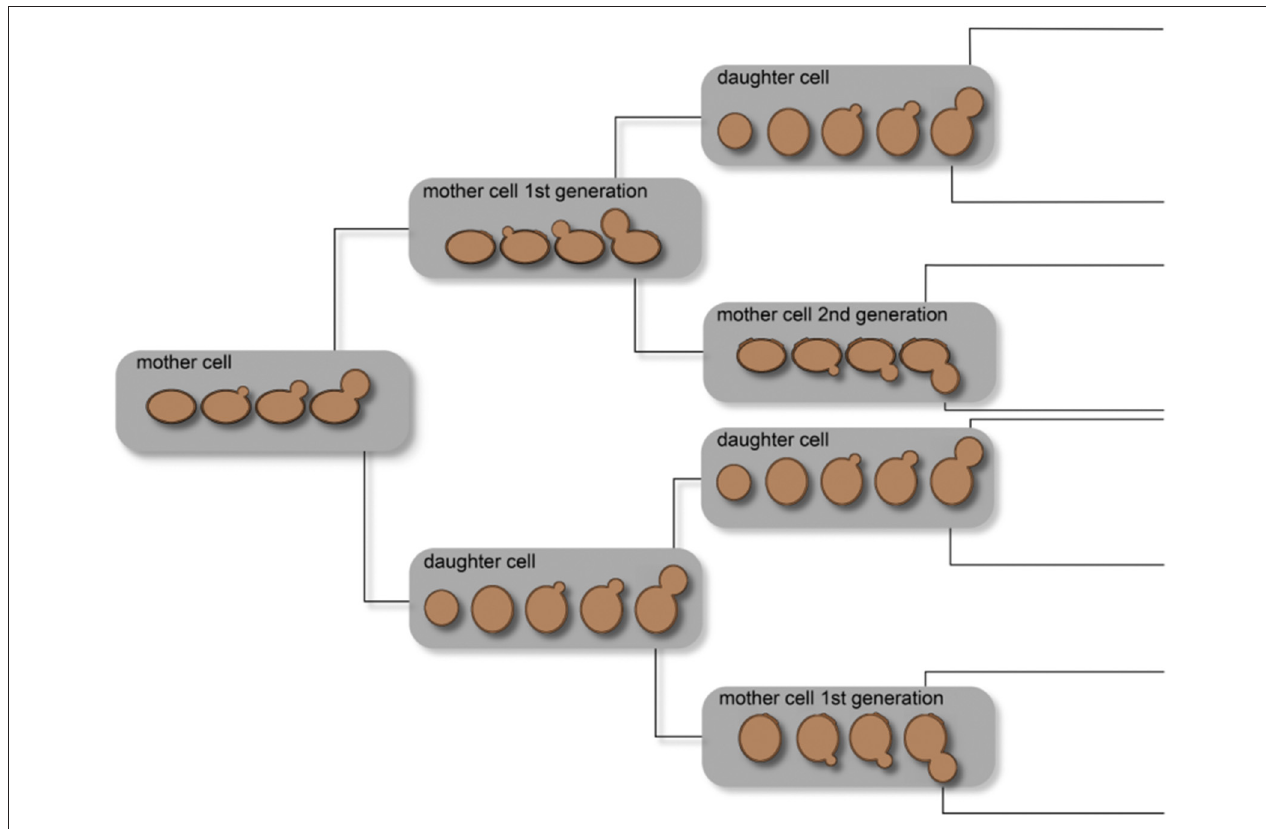
FIGURE 2 | Illustration of the age distribution in yeast cell populations. Owing to the budding process of a mother cell, a daughter cell is created and the mother cell results in a mother cell of the subsequent generation. Thus, a cell culture theoretically consists of 50% daughter cells, 25% mother cells of the first generation, 12.5% of the second generation, and so